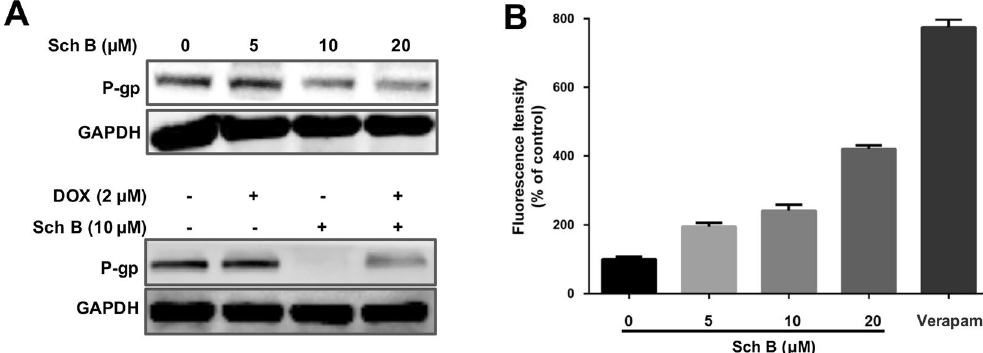
Figure 4. Sch B inhibits P-gp expression and activity. ( A ) Effects of Sch B on the expression of P-gp in MCF-7/ ADR cells. After treatment with Sch B for 48 h, protein levels in cell lysates were analyzed by Western blot. Similar results were obtained in three separate experiments. ( B ) MCF-7/ADR cells was treated with different concentrations of Sch B for 12 h, then P-gp activity was determined using a fluorimetric MDR assay kit. The P-gp inhibitor verapamil (30 µ M) was served as positive control. Results are expressed as mean ± SEM.